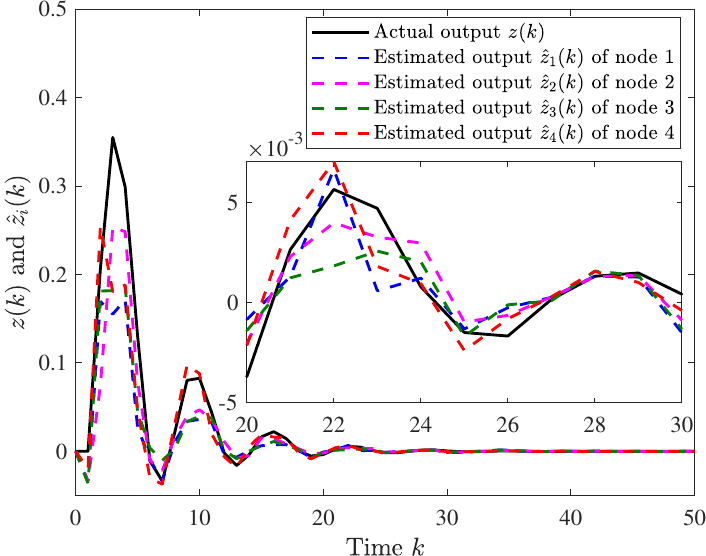
Figure 4. Evolution of plant output z ( k ) and estimated output ˆ z i ( k ) in Case 2, i =